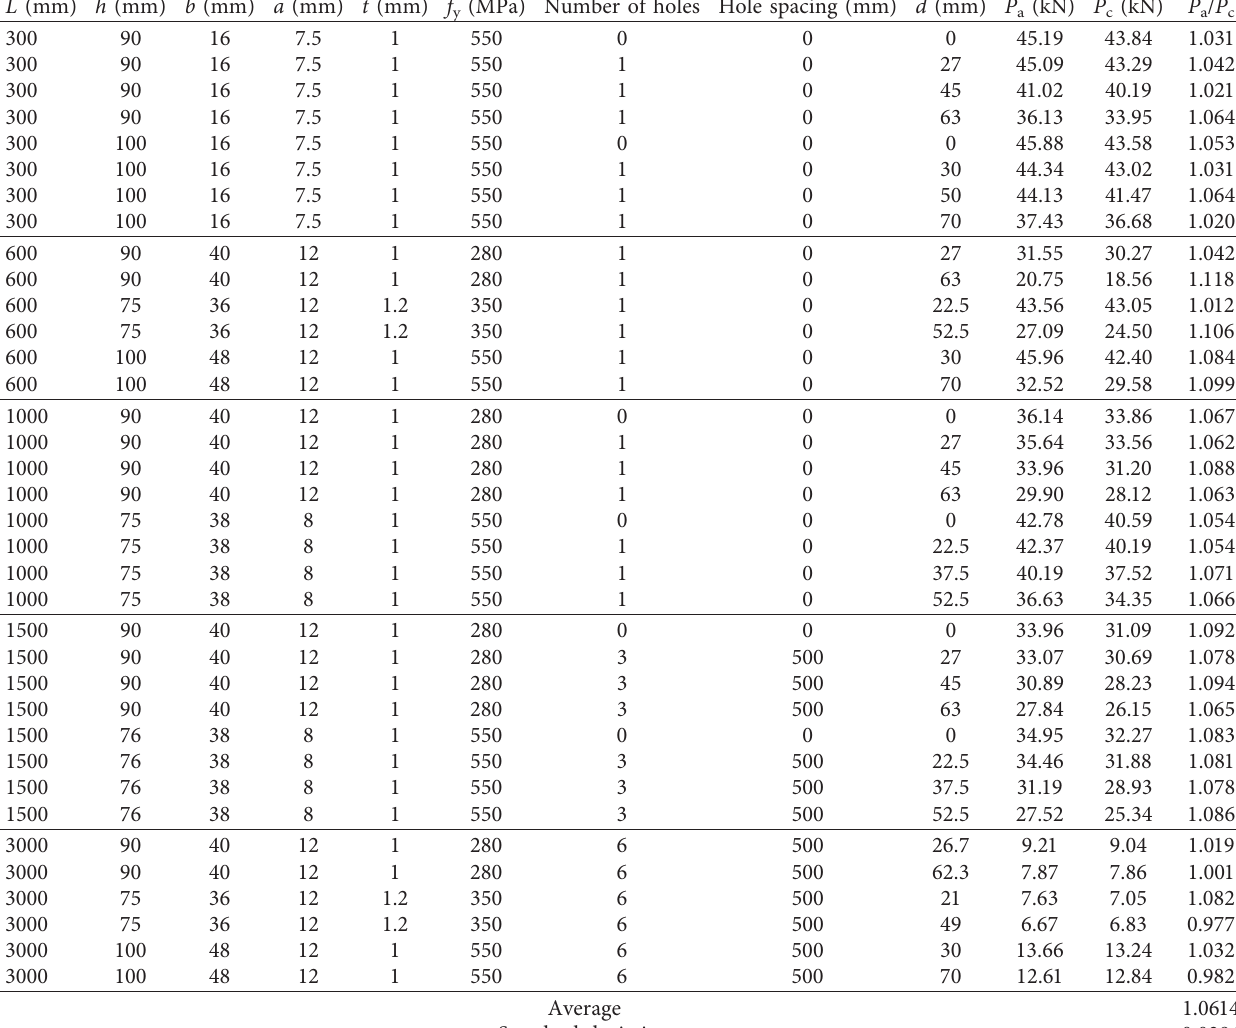
Table 3: Comparison on ultimate loads between FE analysis results and predicted results.